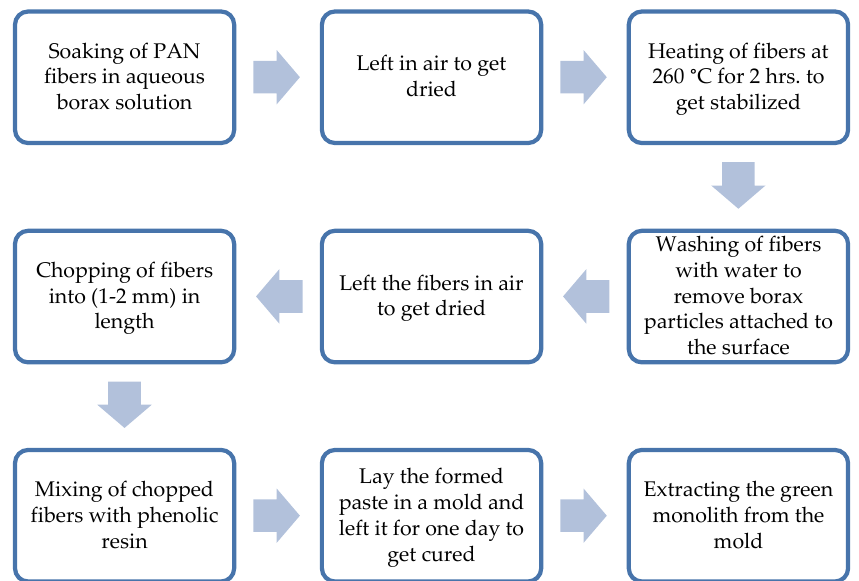
Figure 1. Steps of preparation of the composite green monolith. Note: The green monolith was laid under a pressure of 14 N / cm 2 for eighteen hours at room temperature during the curing process for all the chemically activated samples, while the physically activated samples were not pressed.